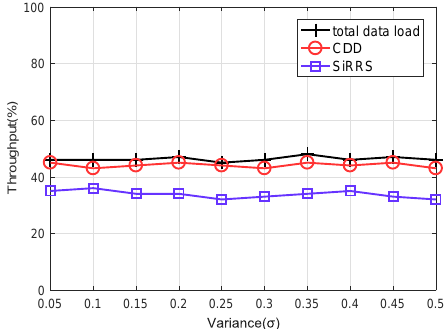
Figure 9. Throughput of light data